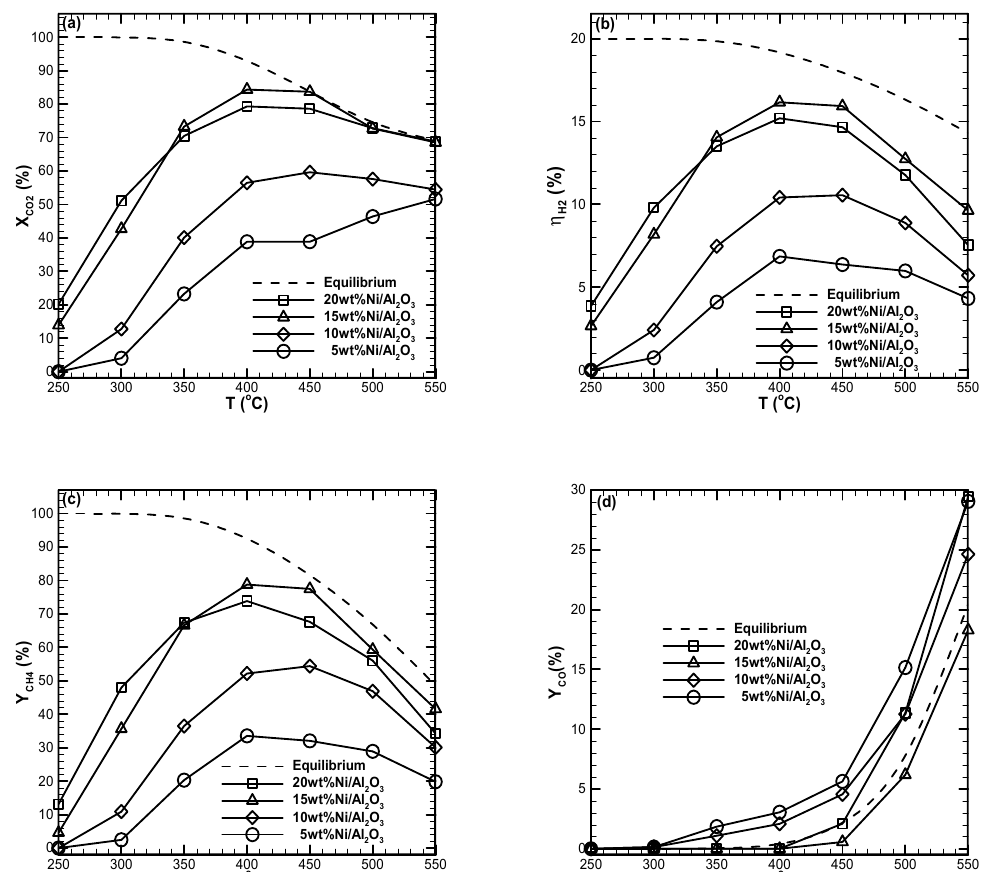
Figure 4. Averaged CO 2 methanation performance as a function of the temperature using Ni catalyst based on Figure 3. ( a ) CO 2 conversion, ( b ) H 2 efficiency, ( c ) CH 4 yield, and ( d ) CO yield.